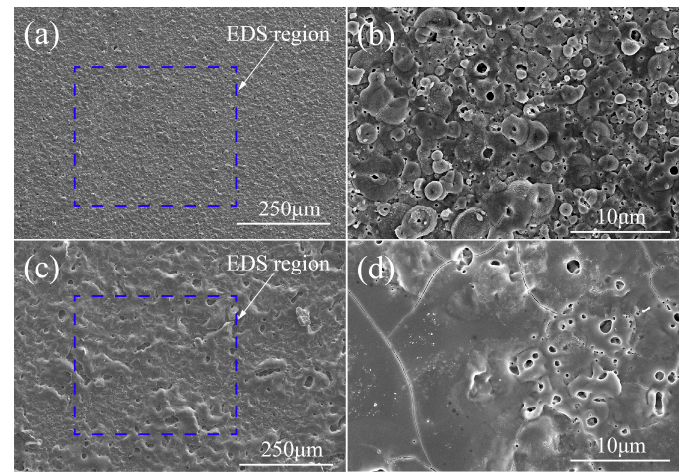
Figure 2. Morphologies of plasma electrolytic oxidation (PEO)-coated AZ31 magnesium alloy. ( a ) Surface morphologies of Al-coating, ( b ) enlargement of framed region in ( a ), ( c ) surface morphologies of Si-coating, ( d ) enlargement of framed region in ( c ).